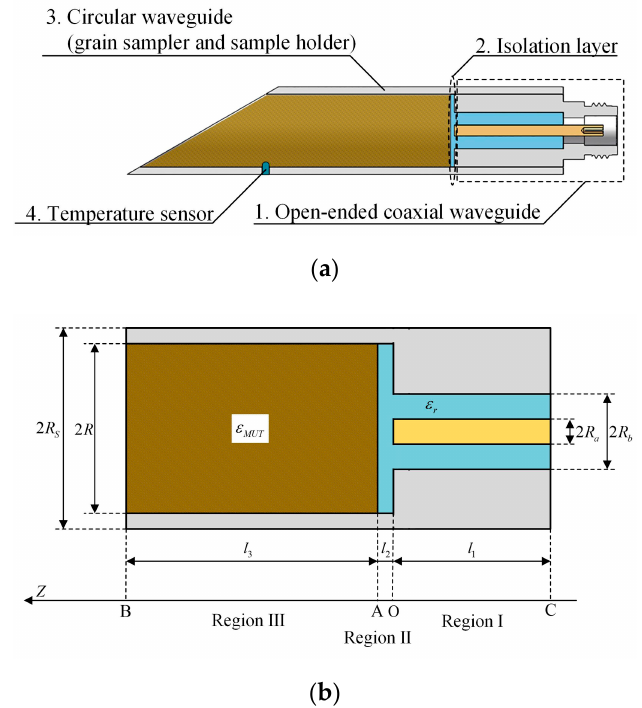
Figure 2. Schematic of the proposed grain moisture sensor: ( a ), schematic of structures; ( b ), sketch of dimensions.